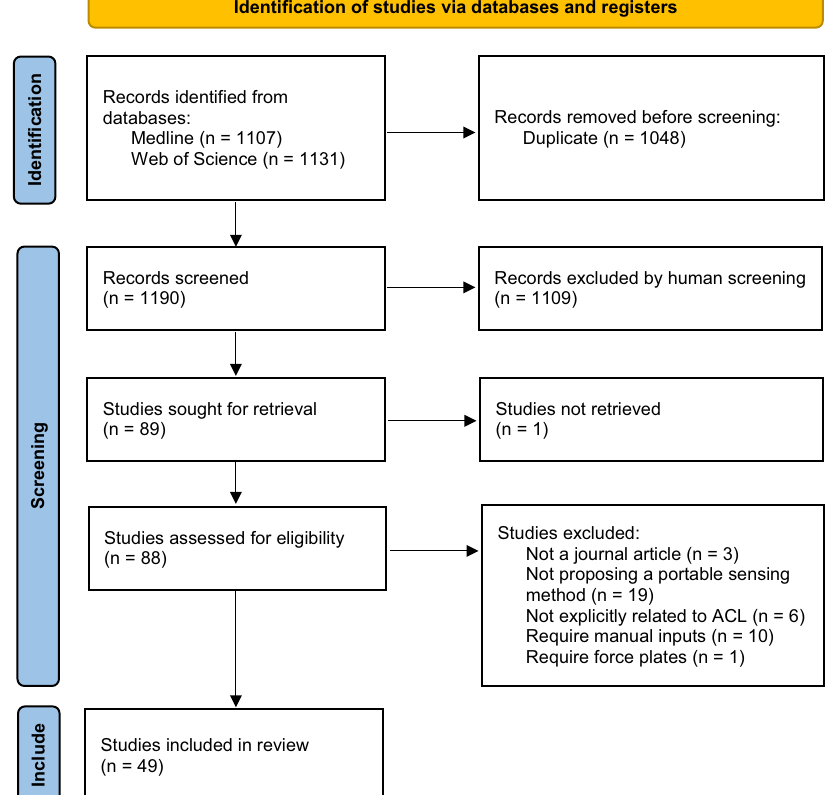
Fig. 1 PRISMA fl ow chart. Search and study selection process for this